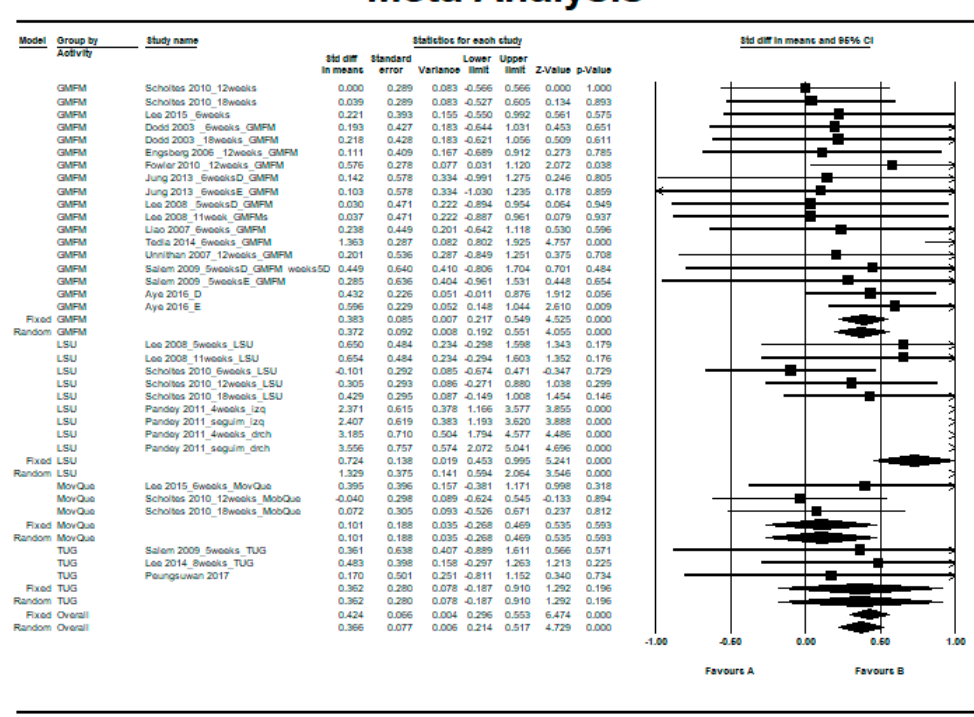
Figure 2. Pre–post intra-group difference in the intervention group with resistance therapy: all measurements and follow-ups.